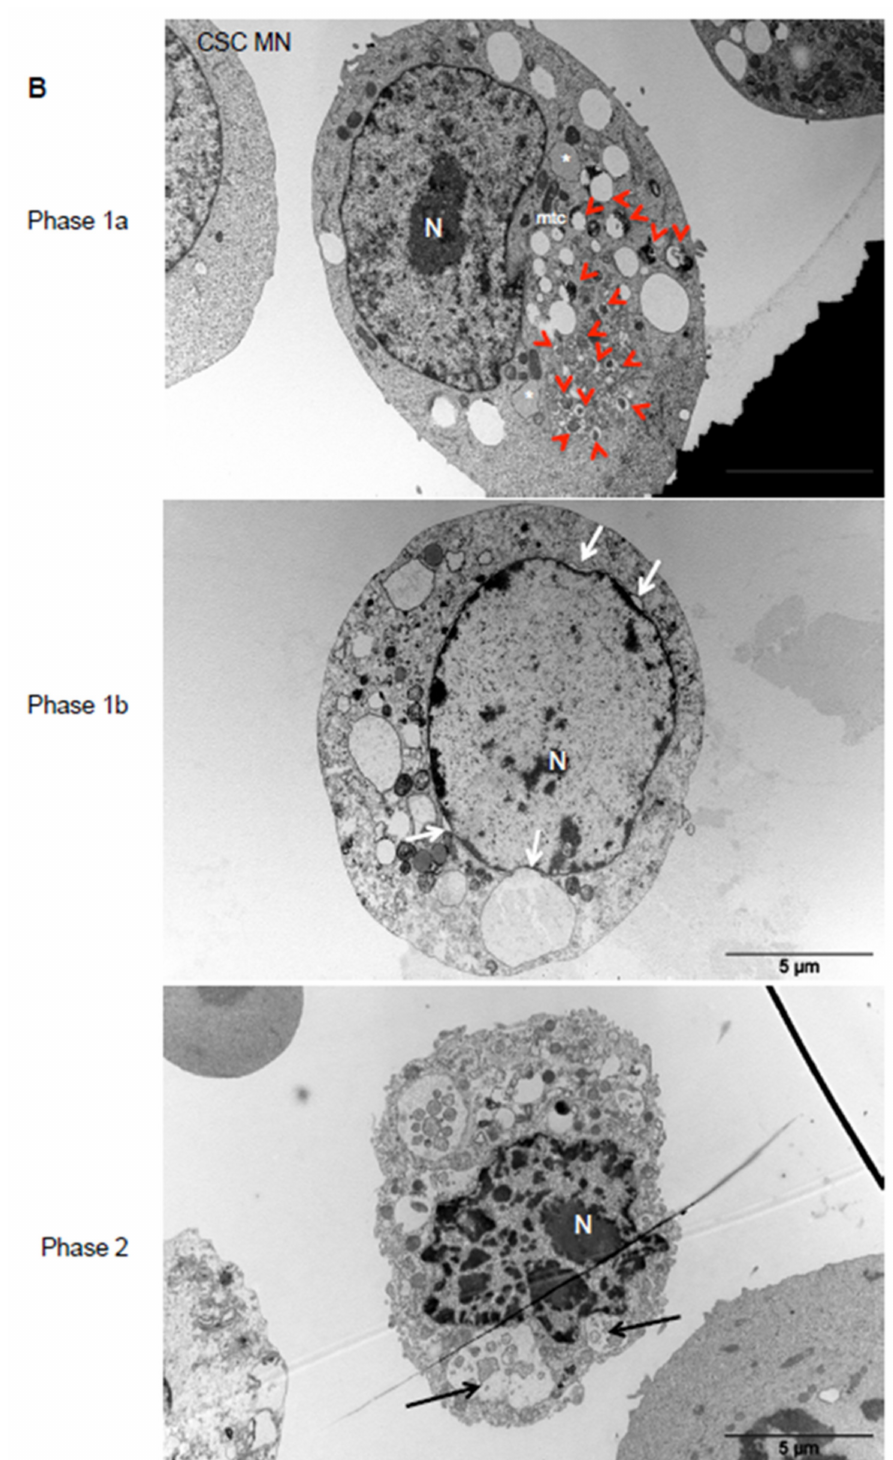
Figure7. MorphologicalfeaturesofTZ-inducedcelldeathevokesautosis, aNa +/ K + ATPase-dependent cell death. Representative TEM pictures of the di ff erent phases of TZ-induced cell death. UMR ( A ) and MN ( B ) CSC-enriched cells were treated with di ff erent TZ concentrations (8 or 20 µ M) for various periods (3 h 30 to 24 h) and representative pictures of the di ff erent phases of autosis are shown. Autophagic vesicles (red arrowheads), electron-dense mitochondria (mtc) and endoplasmic reticulum (ER) dilatation (*) are observed in phase 1a. Local separation of the inner and outer nuclear membranes (white arrows) is shown in phase 1b. Focal ballooning of the perinuclear space (black arrows) and lysis of the plasma membrane are observed in phase 2. N: